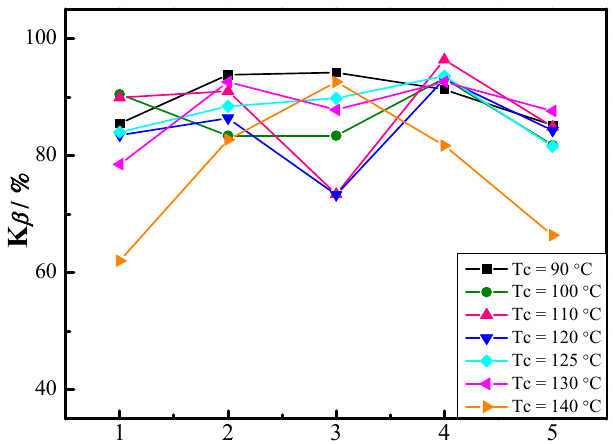
Figure 2. K β values of TMB-5 nucleated iPP statically crystallized at each individual crystallization temperatures, the NA content is 0.1 wt%. The horizontal axis numbers 1–5 correspond to iPP/0.1TMB-5 UT , iPP/0.1TMB-5 DMSO , iPP/0.1TMB-5 DMF , iPP/0.1TMB-5 ODCB and iPP/0.1TMB-5 LP , respectively.